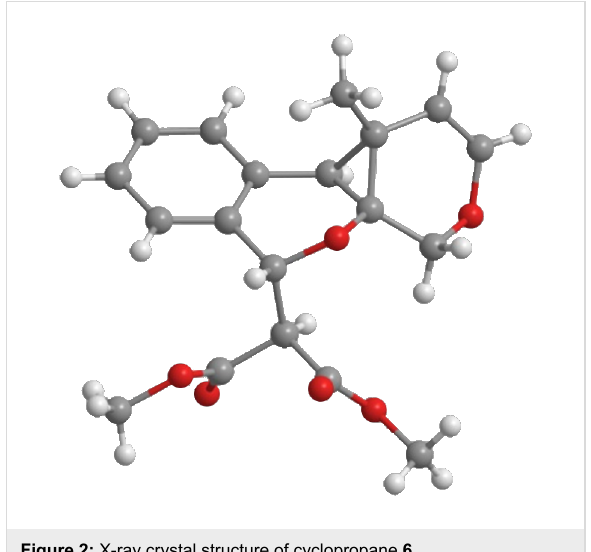
Figure 2: X-ray crystal structure of cyclopropane 6